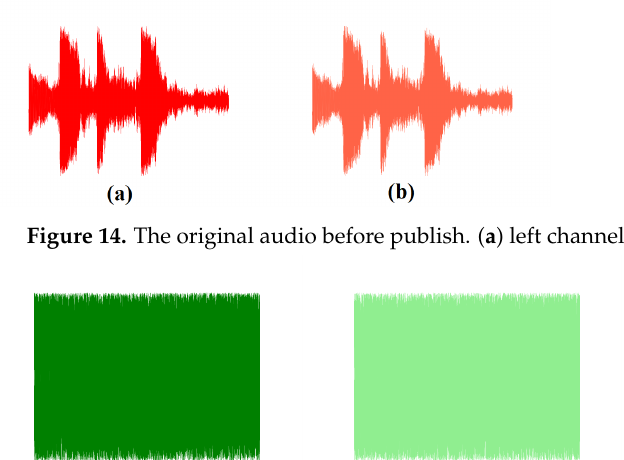
Figure 13. Raspberry Pi 1 as Publisher, Laptop as Broker, Raspberry Pi 2 as Subscriber.